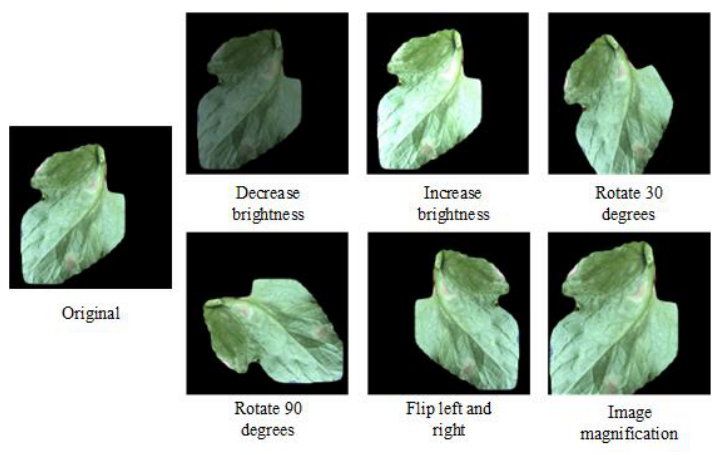
Figure 3. Data enhancement example.